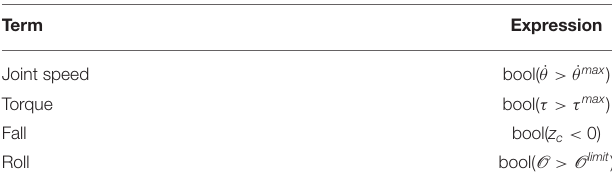
TABLE 7 | Safety constraint